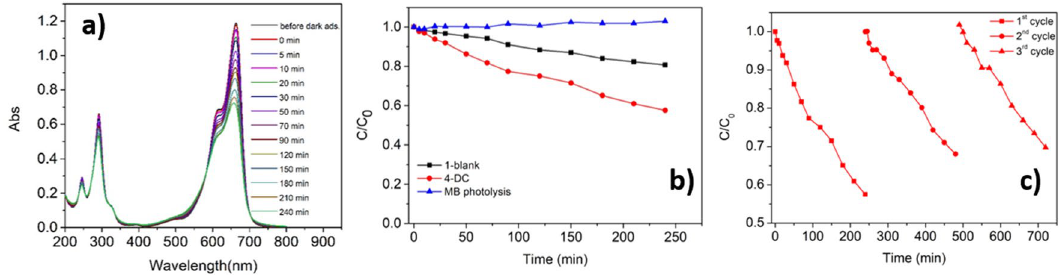
Figure 4. Photodegradation of an aqueous solution of MB 1.8 × 10 –5 M: ( a ) variation of the UV–Vis absorption spectra of MB under UV irradiation in the presence of the photocatalyst 4-DS; ( b ) variation of the concentration of MB in time through photolysis (blue line), photocatalysis with 1-blank (black line) and 4-DS (red line) samples; ( c ) recycling experiments: variation of the concentration of three solutions of MB (1.8 × 10 –5 M) versus time under UV irradiation in the presence of the same 4-DS sample reused for three